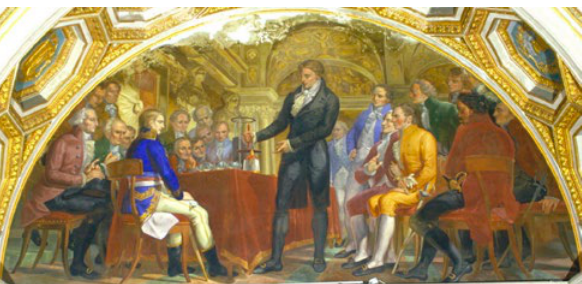
Figure 4. Alessandro Volta presents his battery (Voltaic pile) to Napoleon